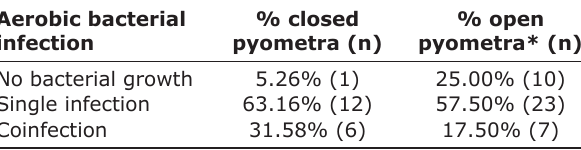
Figure-3: Percentages of bacteria isolated from uterine content culture of closed (n = 18) and open (n = 30) pyometra groups susceptible to antimicrobial drugs. Table-8: Percentages of aerobic bacterial infections from uterine content of closed (n=19) and open (n = 40) pyometra groups.